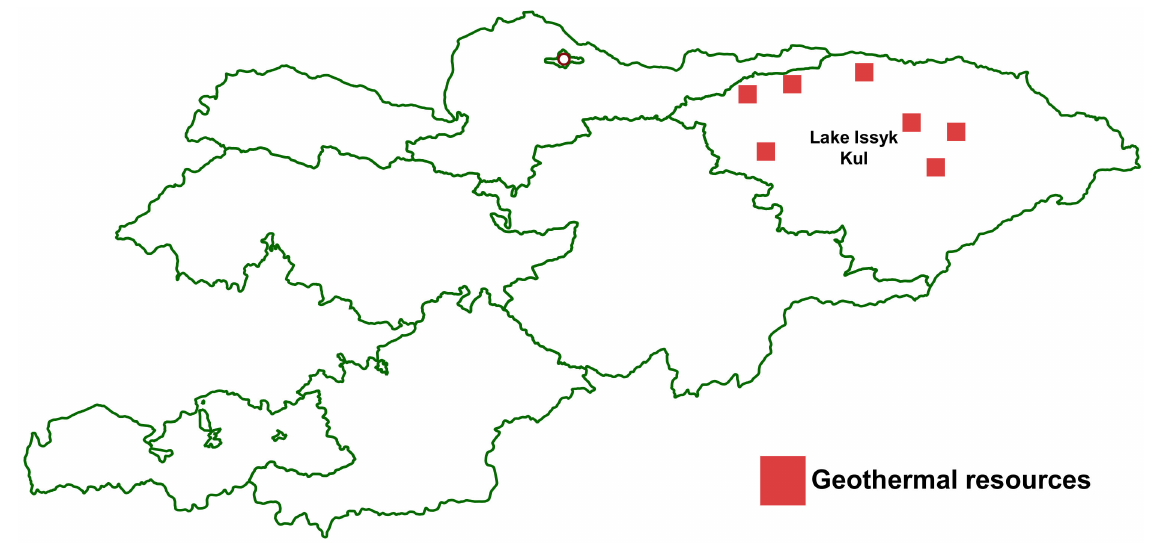
Figure 7. Geothermal resources available in Kyrgyzstan (data according to